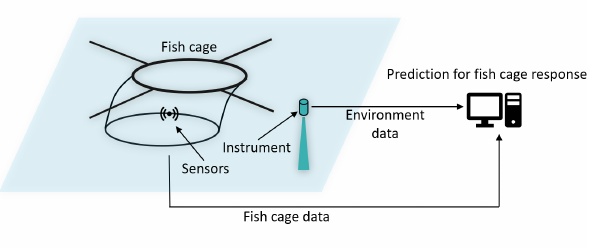
Figure 1: Concept of online cage response